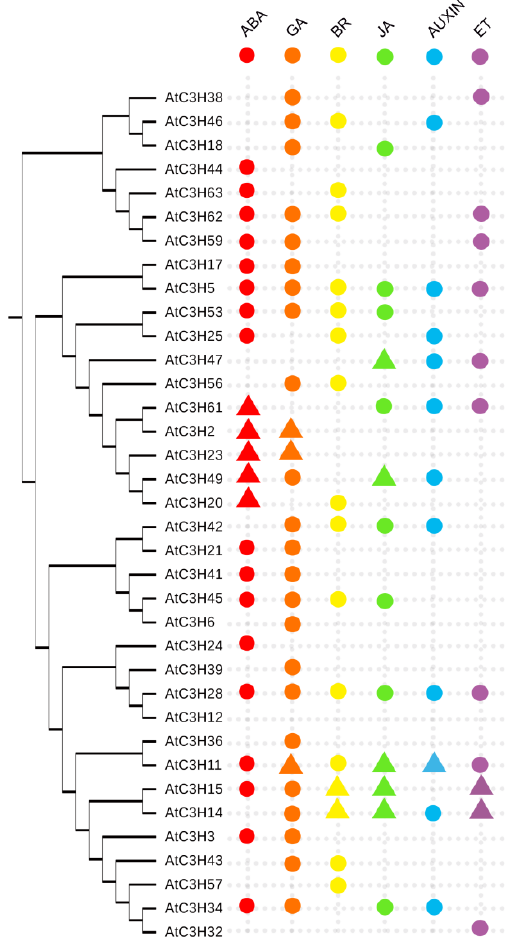
Figure 4. Responses of Arabidopsis CCCH genes to multiple hormones. The responses of 36 CCCH genes to six hormones (represented by different colored dots or triangles) were predicted using the Arabidopsis eFP browser. The phylogenetic tree was constructed based on the alignment of full–length Arabidopsis CCCH proteins. The CCCH protein shown with triangle has been character- ized